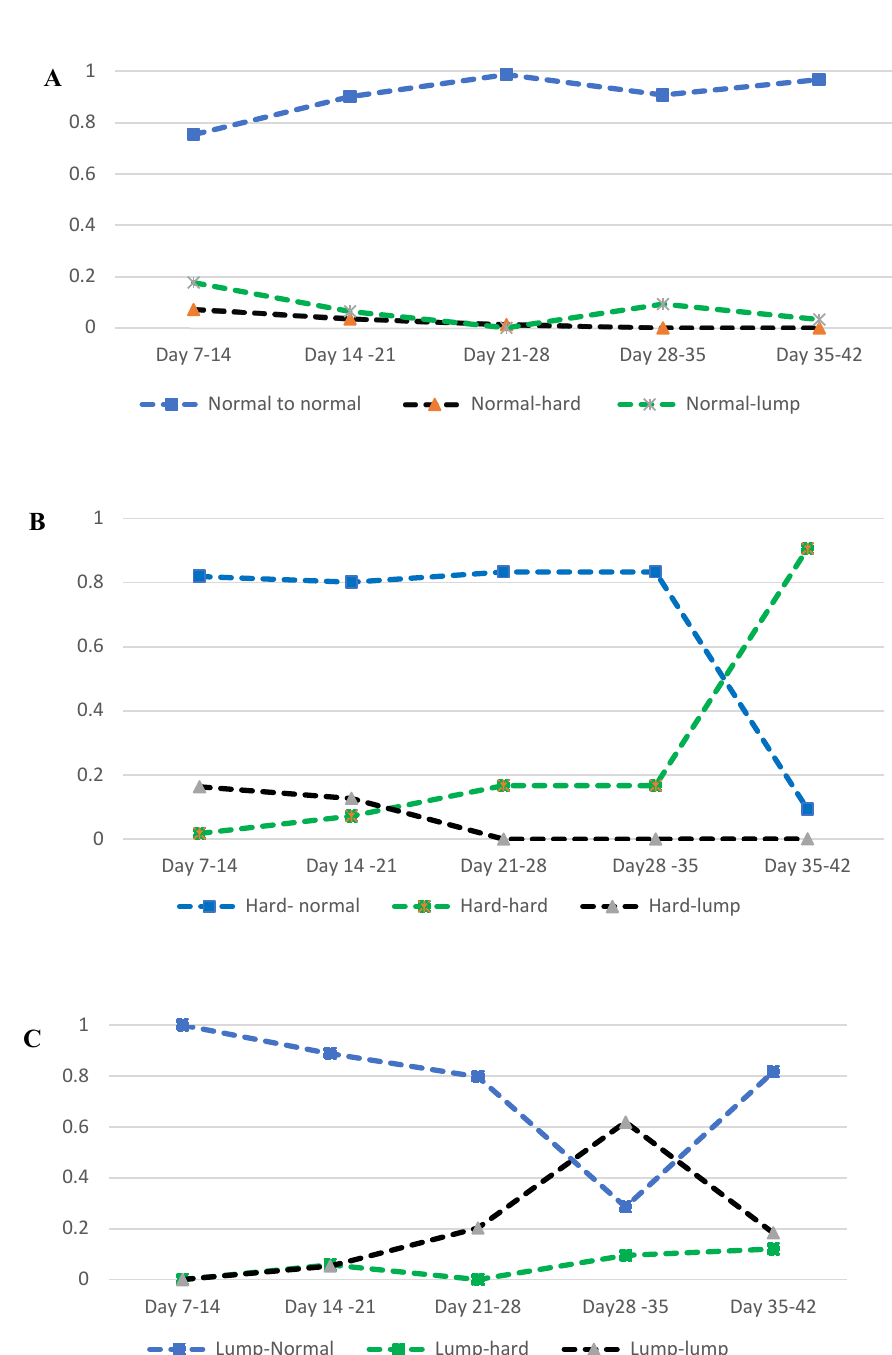
Figure 3. Line graph of the transitional probability of udder half defects in the first six weeks of lactation from 92 udder halves (from 46 non-dairy Romney ewes) in 2019 (Study B). ( A ) Transitional probability of udder half defect from preceding normal state; ( B ) Transitional probability of udder half defect from preceding hard state; ( C ) Transitional probability of udder half defect from preceding lump state. Probabilities were predicted conditionally on the preceding udder palpation event (e.g., Day 7 udder defect status was used to predict Day 14 udder defect status, Day 14 for Day 21, and so forth for the six examinations during lactation).